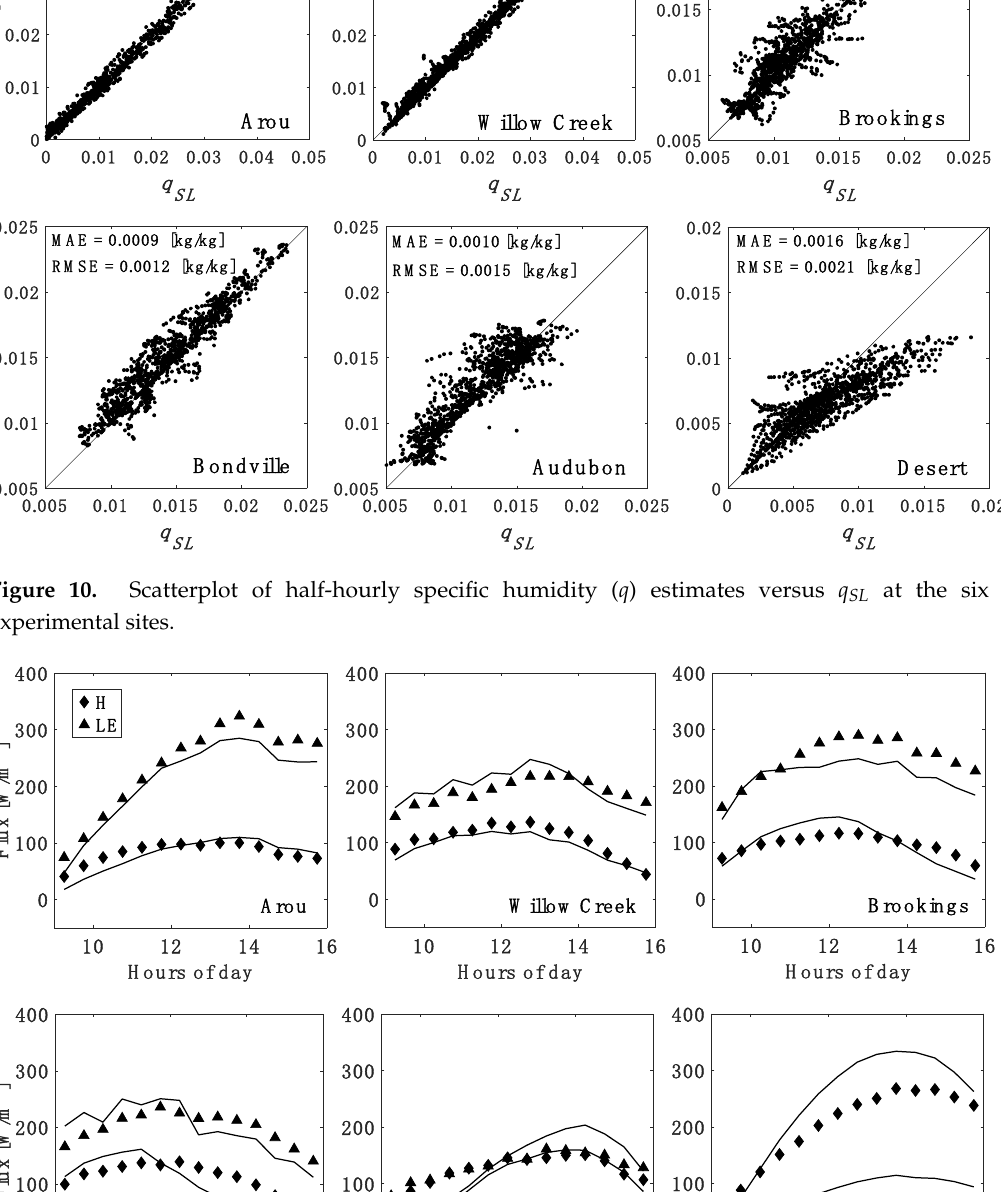
Figure 9. Scatterplot of half-hourly potential temperature ( θ ) estimates from VDA versus (cid:2242) (cid:2175)(cid:2168) at the six experimental sites.